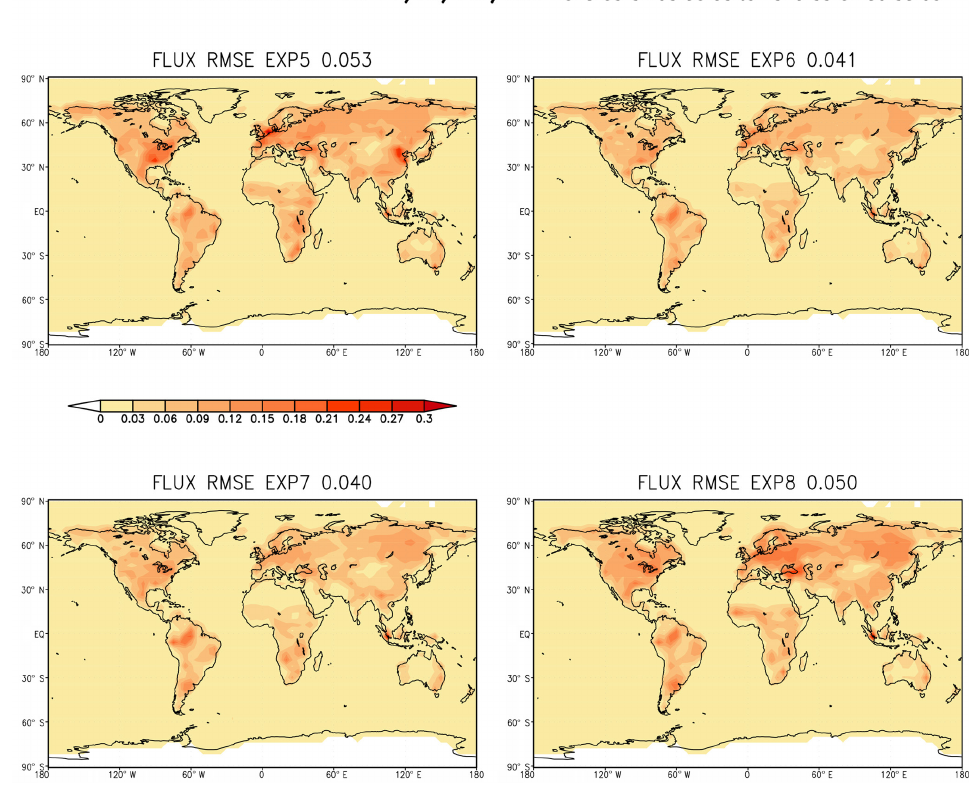
Figure 5. Same as Fig. 3, except for the second set of experiments with different OW but similar AW of 1d.